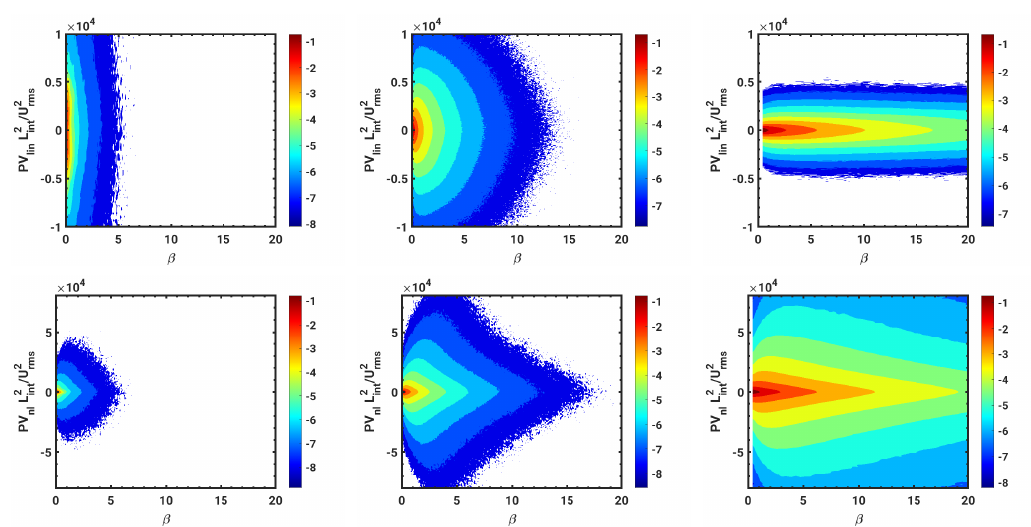
Figure 8. Joint PDFs of linear ( top ) and nonlinear ( bottom ) potential vorticity, both adimensionalized using = [ L ] 2 . Plots are for the three fiducial runs with, as before, rI at left, rII in the middle and rIII at right τ 2 int / U rms NL (see Table 1). Note the different vertical scales between the linear and nonlinear PV